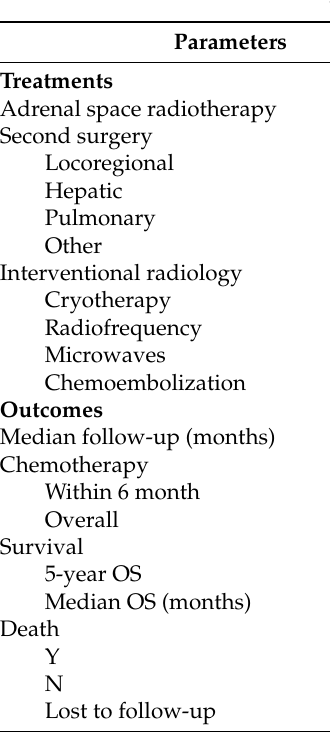
Table 2. Treatments and outcomes